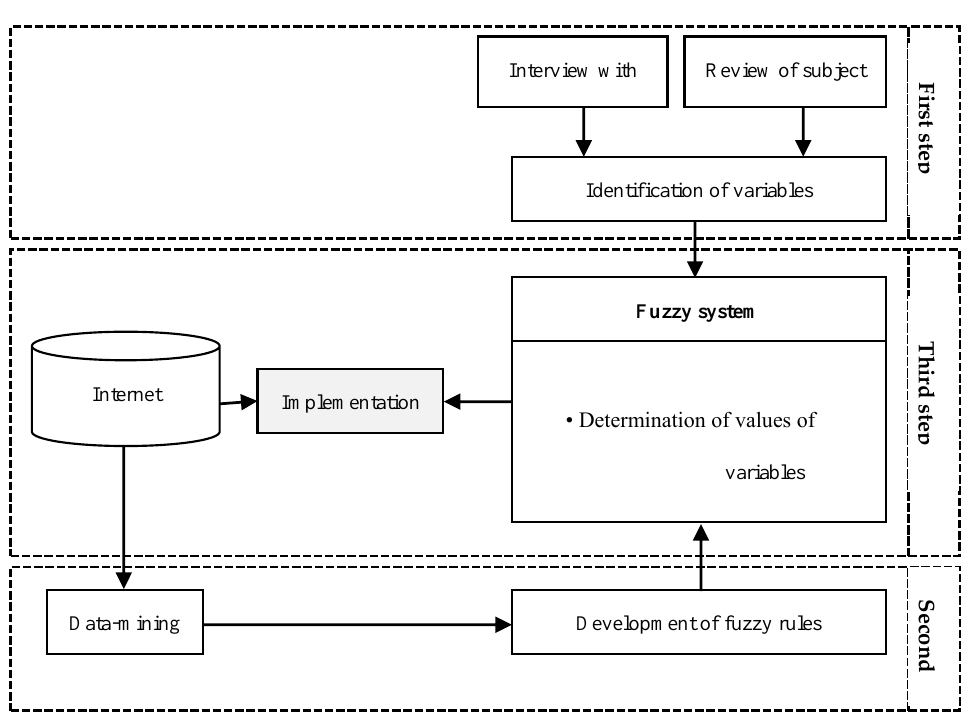
Figure 1. Research implementation process.